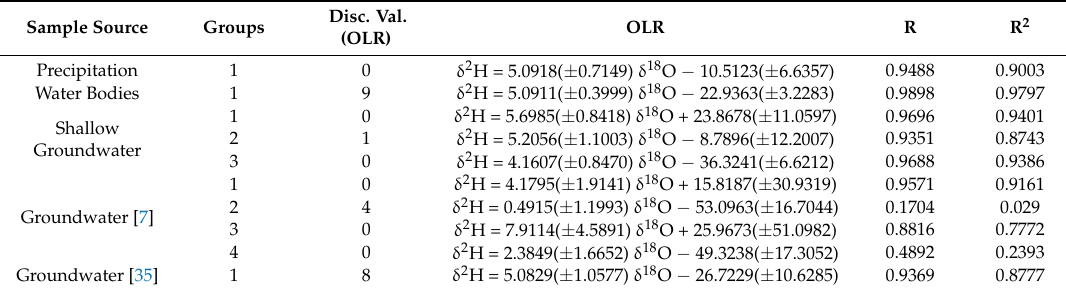
Table 2. Ordinary least-squares linear regression parameters from stable isotopic compositions of all water sources.